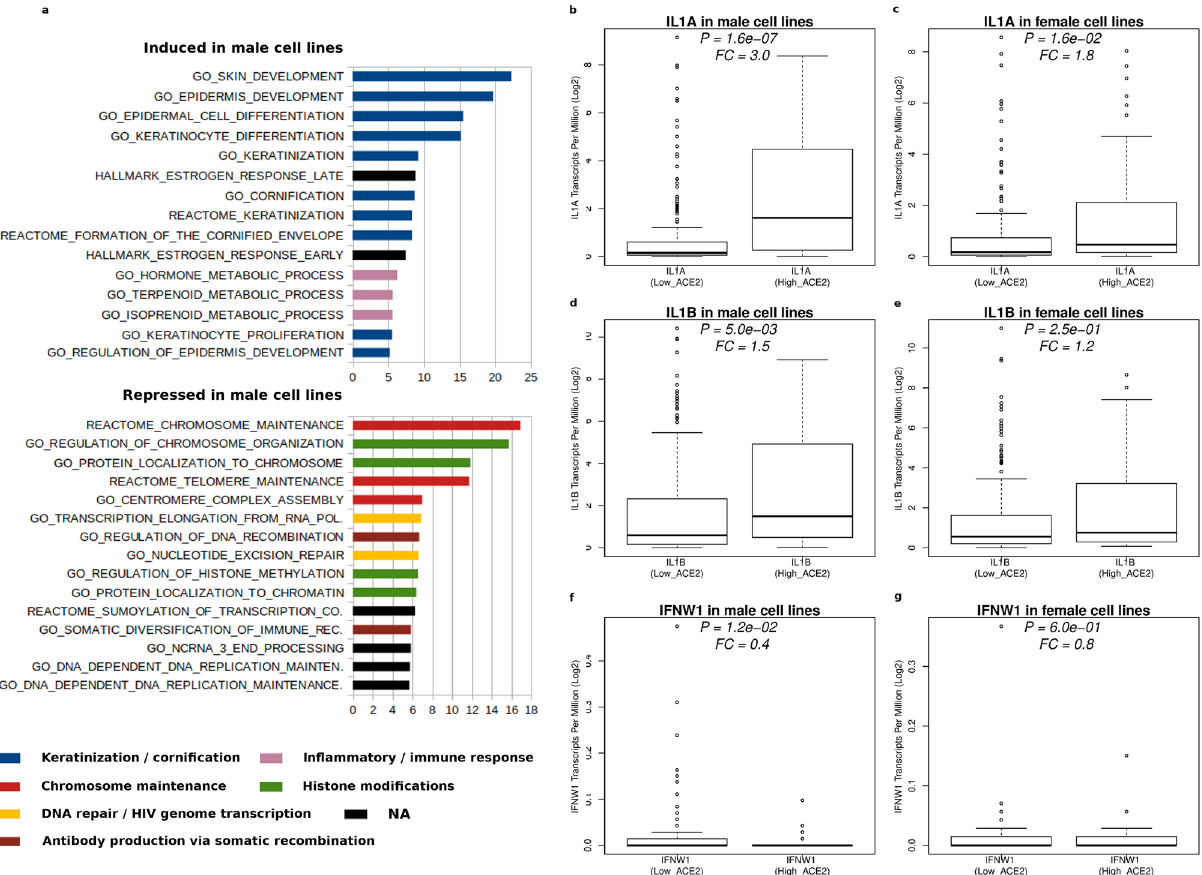
Figure 5. Gender-preferential pathway expression links ACE2 overexpression to worse clinical outcome in males. Measurement of the gender specific activation of the pathways associated to ACE2 overexpression identified 131 gene sets with significant gender preferential activity, with the top 30 lists shown in ( a ). Disease- linked genes IL1A ( b , c ), IL1B ( d , e ) and IFNW1 ( f , g ) also show preferential activation in